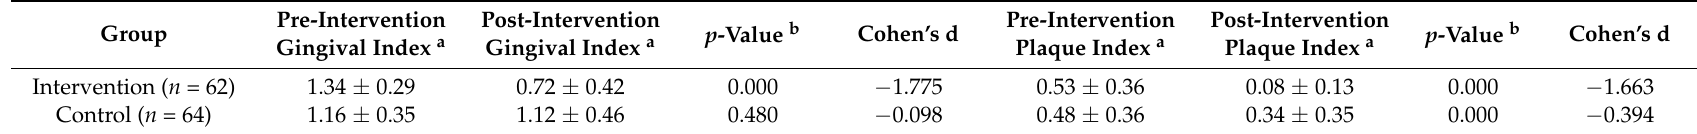
Table 2. Within-group measurements and effects of primary and secondary outcome variables.